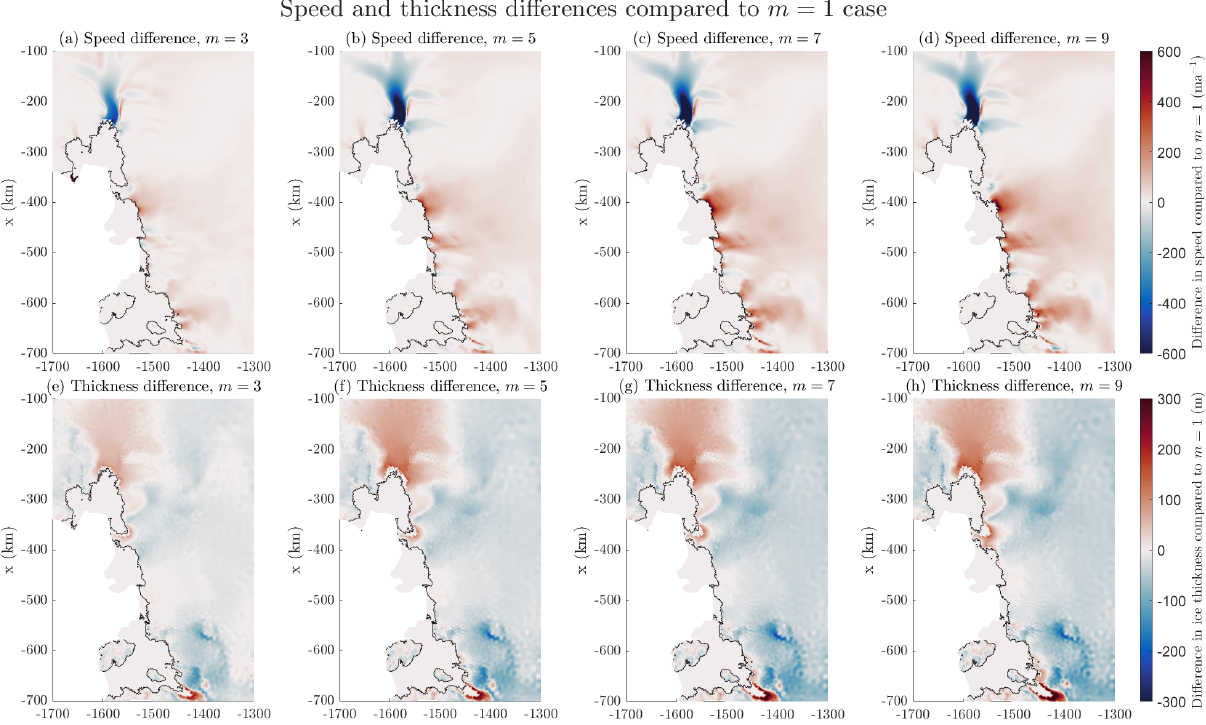
Figure 5. Differences in final speed (a–d) and ice thickness (e–h) in the ice shelf removed branch for the Weertman sliding law. All other values of m are compared to the case where m = 1. Areas which are not grounded in either case are not shaded as part of each